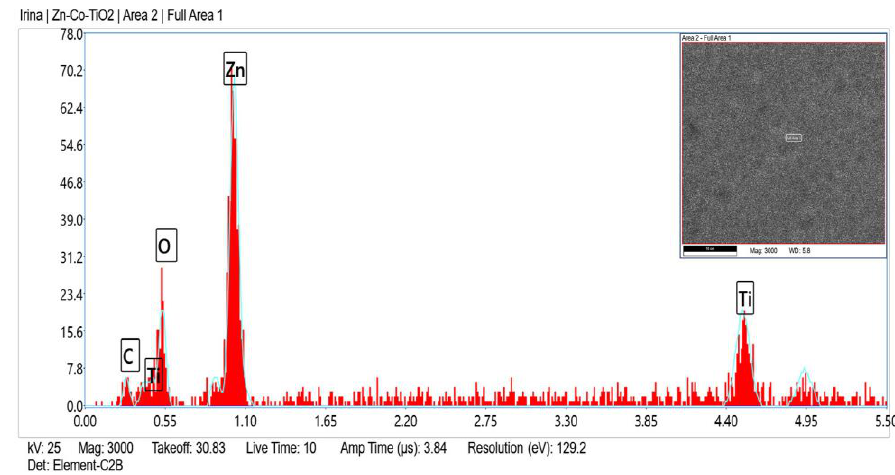
Figure 4. SEM images of System B — fresh sample (left): magnification 3000 ( a ) and 10,000 ( b ) and after corrosive treatment (right): magnification 3000 ( c ) and 10,000 ( d ).